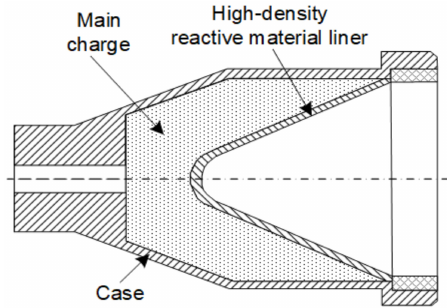
Figure 3. Diagram of high-density reactive material liner shaped charge.